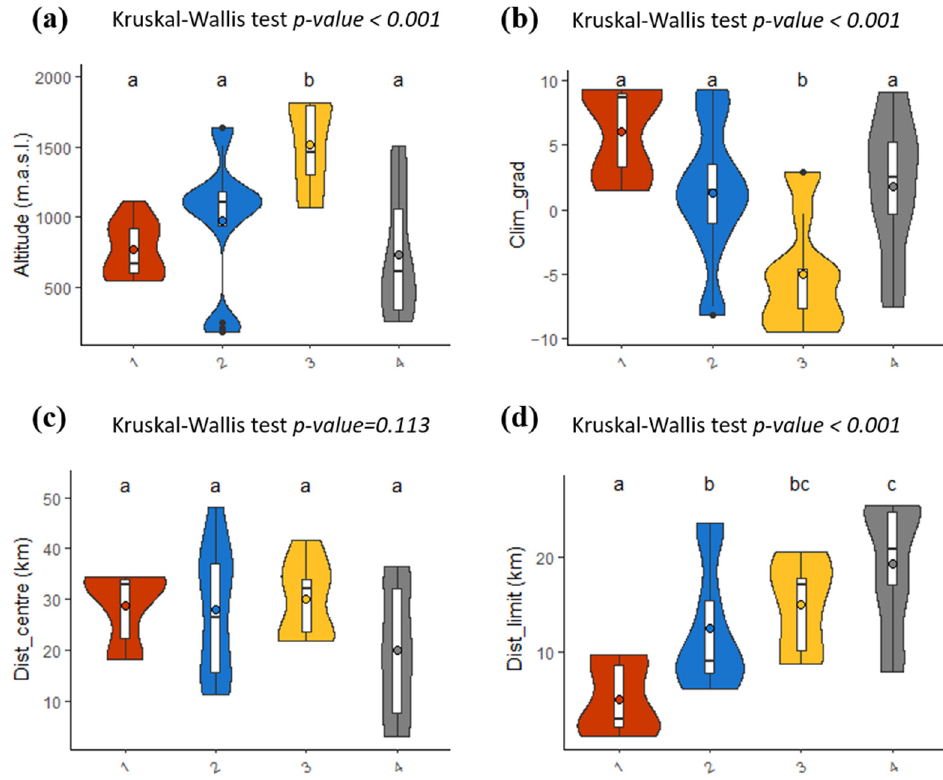
Figure 6. Differences in position along ecological gradients and in relation to geographic distribution limits for the four main micro-niche types of Lilium pomponium . Ecological position is expressed in relation to ( a ) altitude and ( b ) climatic gradients based on the main axis of principal component analysis (PCA) of monthly meteorological data). Geographic locations of sites represent Euclidian distance to either ( c ) the centre or ( d ) distribution limits. Kernel density for each micro-niche type shows quartiles (boxplot) and mean values (coloured circle). Code letters indicate that micro-niche means are significantly ( p < 0.05) different in pair-wise Wilcoxon tests with Bonferroni adjustment.